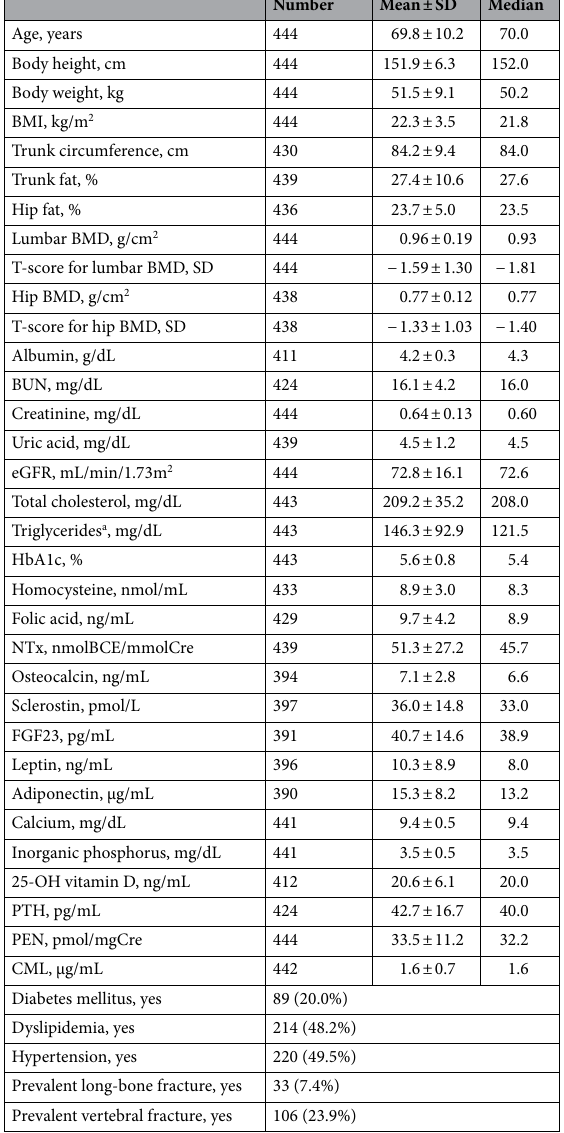
Table 1. Characteristics of study patients. SD standard deviation, BMI body mass index, BMD bone mineral density, BUN blood urea nitrogen, eGFR estimated glomerular filtration rate, HbA1c hemoglobin A 1c , NTx